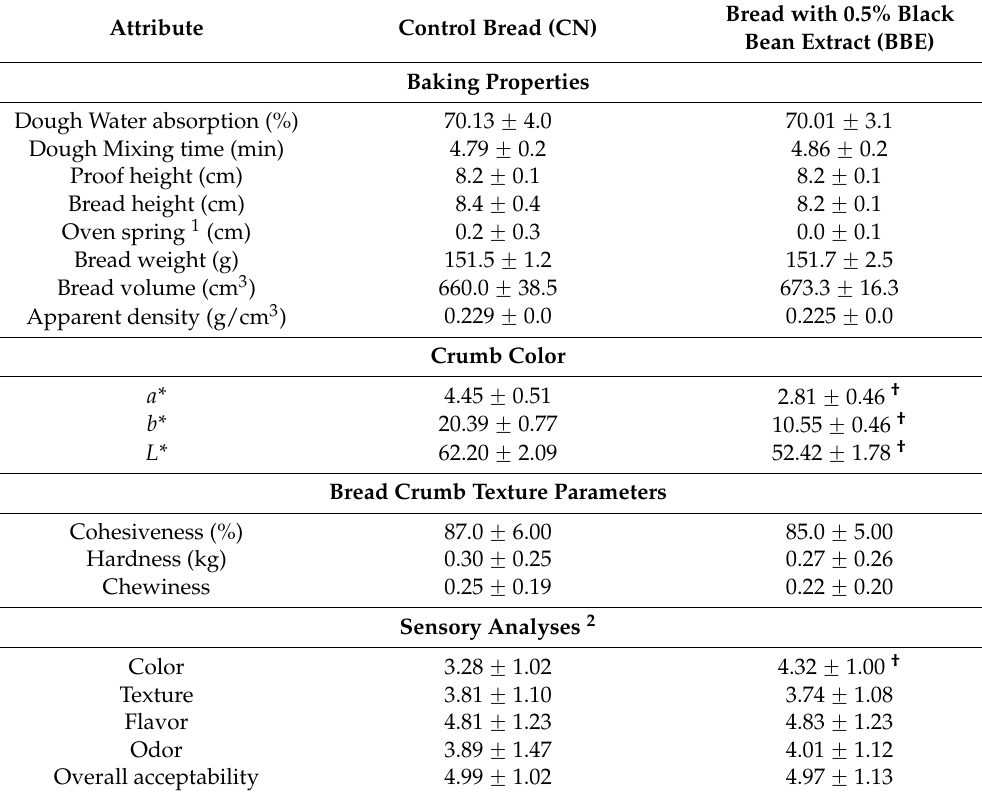
Table 1. Effect of the addition of black bean extract (FDE) on the physical characteristics of breads prepared with the straight-dough procedure.